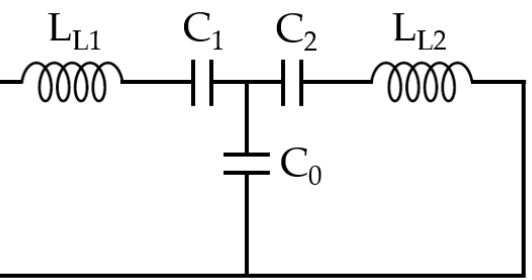
Figure 6. Proposed Z-source circuit breaker with mechanical switch simplified schematic.